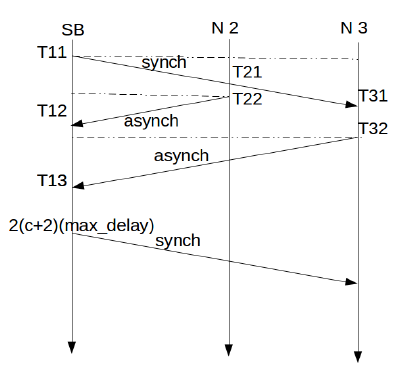
Figure 1. Synchronization